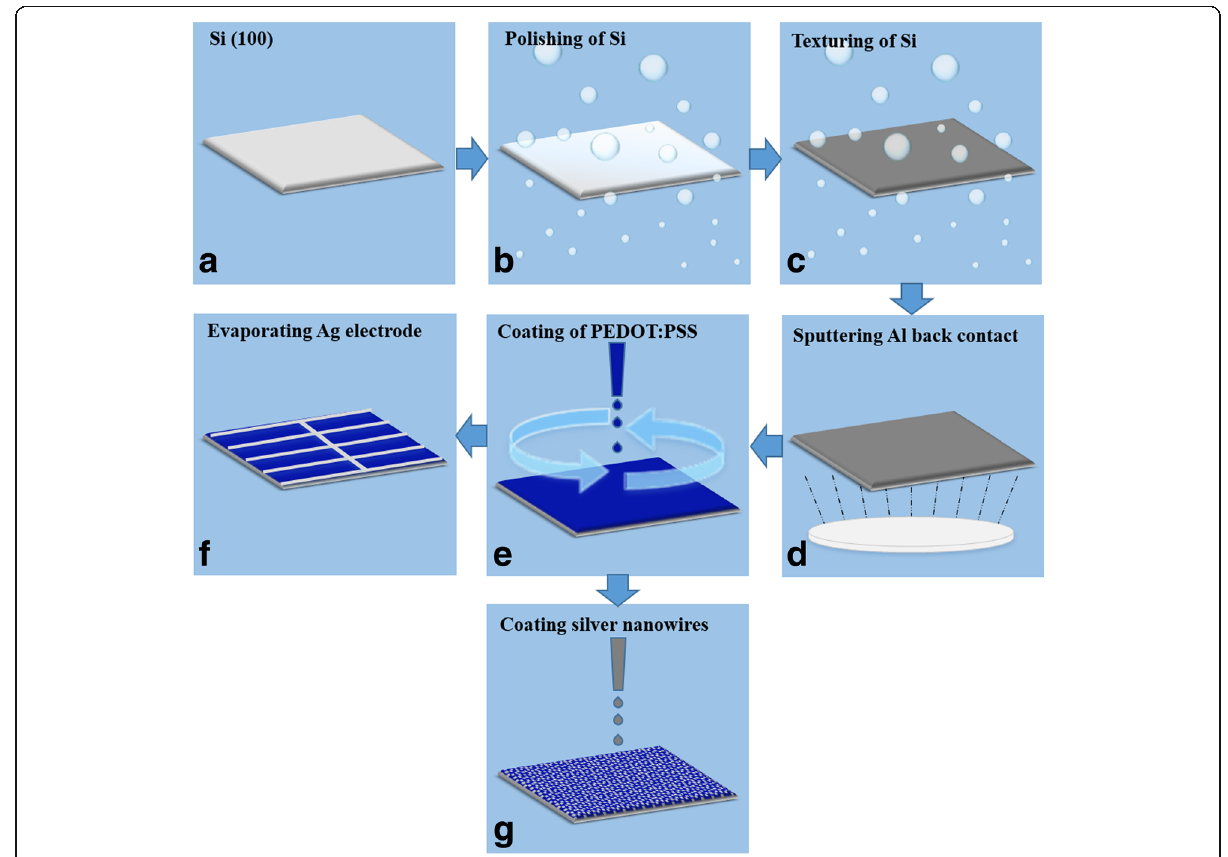
Fig. 1 Schematic of preparing the n-Si/PEDOT:PSS solar cells with ( a-f ) Ag grid electrodes or ( a-e, g ) silver nanowires